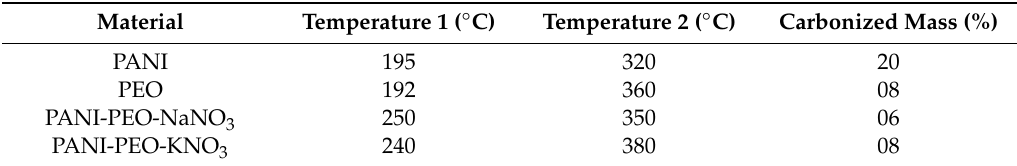
Table 1. Stability of PANI, PEO and its